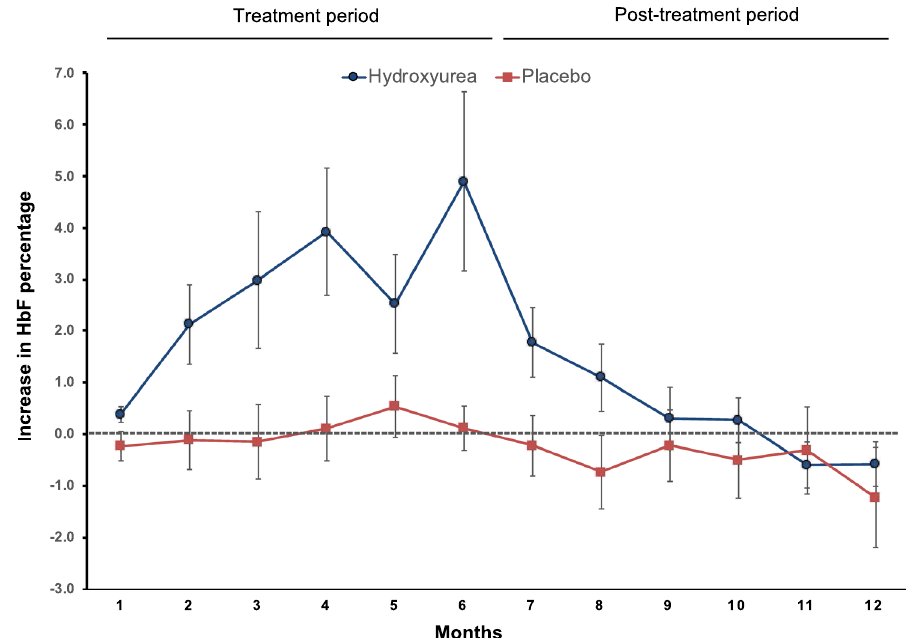
Figure 2. Line diagram showing the trends of rise in fetal haemoglobin percentage during treatment and post- treatment period. Mean increase of fetal haemoglobin from the baseline in hydroxyurea and placebo arms are shown. Error bars represent the standard error of mean. The mean and standard deviation values are given in Supplementary Table 2 (Figure created using Microsoft Excel version 16.57).